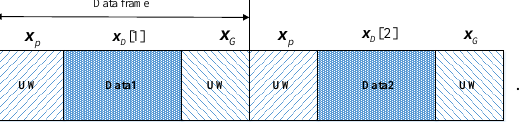
Fig. 1. Transmission data frame structure